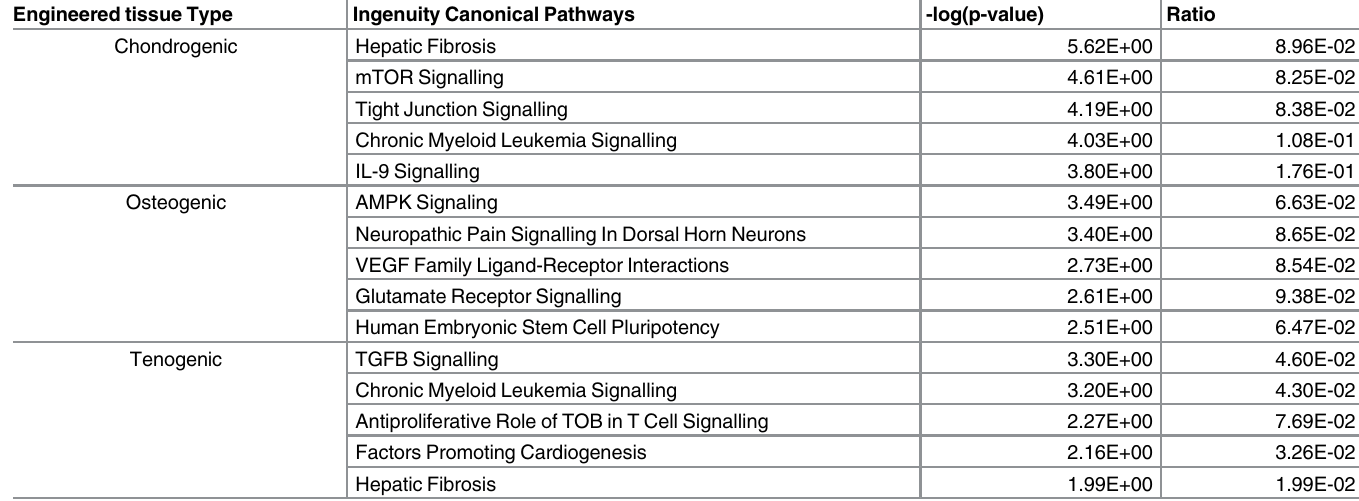
Table 9. The five significant canonical pathways related to changes in the methylation patterns for each tissues type. The log (p-value) of each path- way was determined using Fisher ’ s exact test. The ratios were calculated as the number of input molecules mapped to a specific pathway divided by the total number of molecules in the given